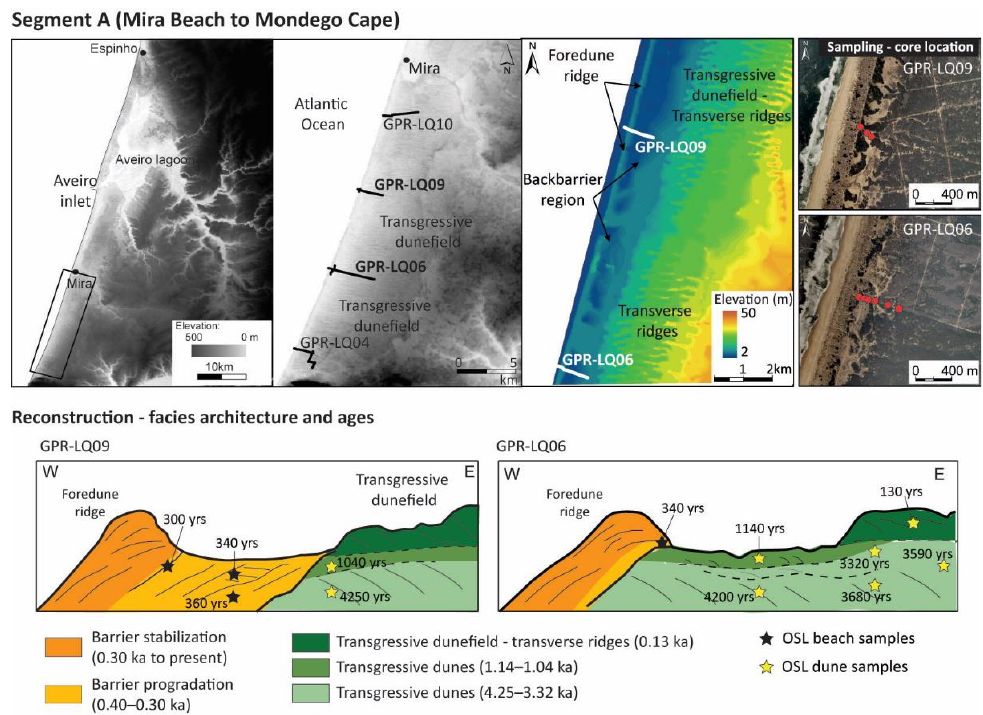
Figure 2. Detail of the location of the site Segment A, the morphology of the modern barrier and inland transverse ridges conforming to the fixed transgressive dune field and the reconstruction of the evolution of the area based on Costas et al. [17].